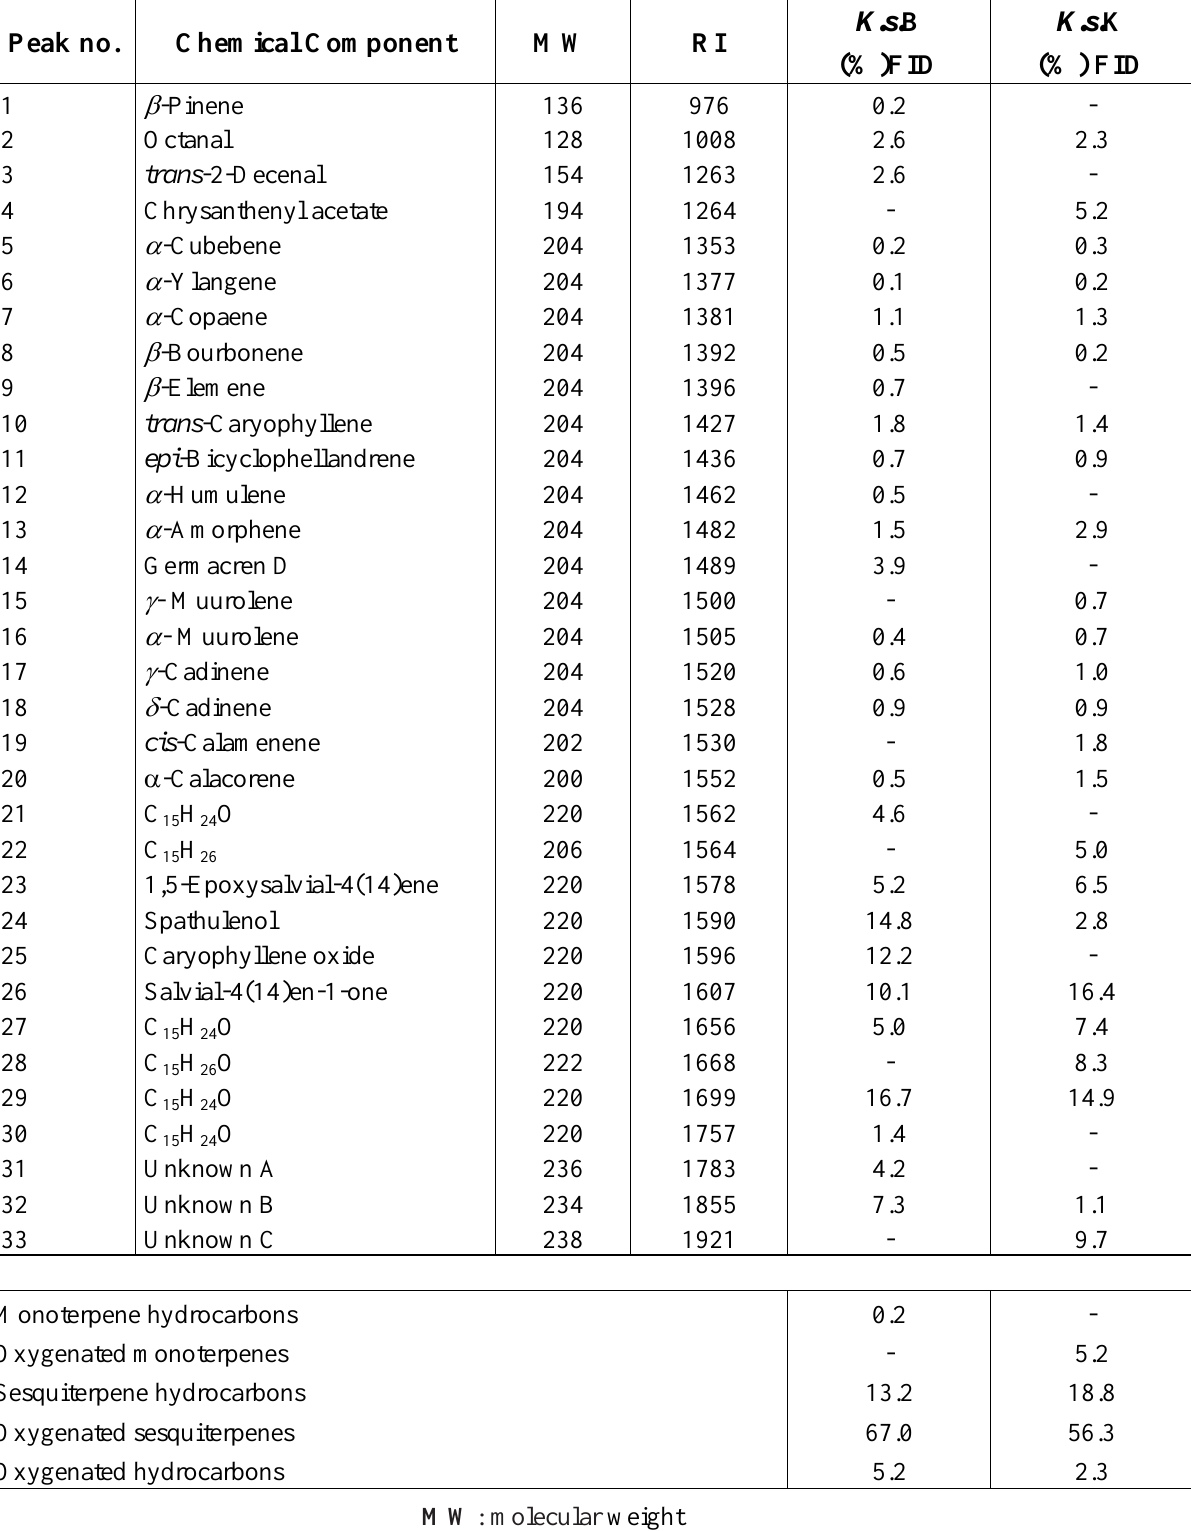
Table 1 . Percentage composition of the essential oil of the aerial parts of Kundmannia sicula DC. Peak